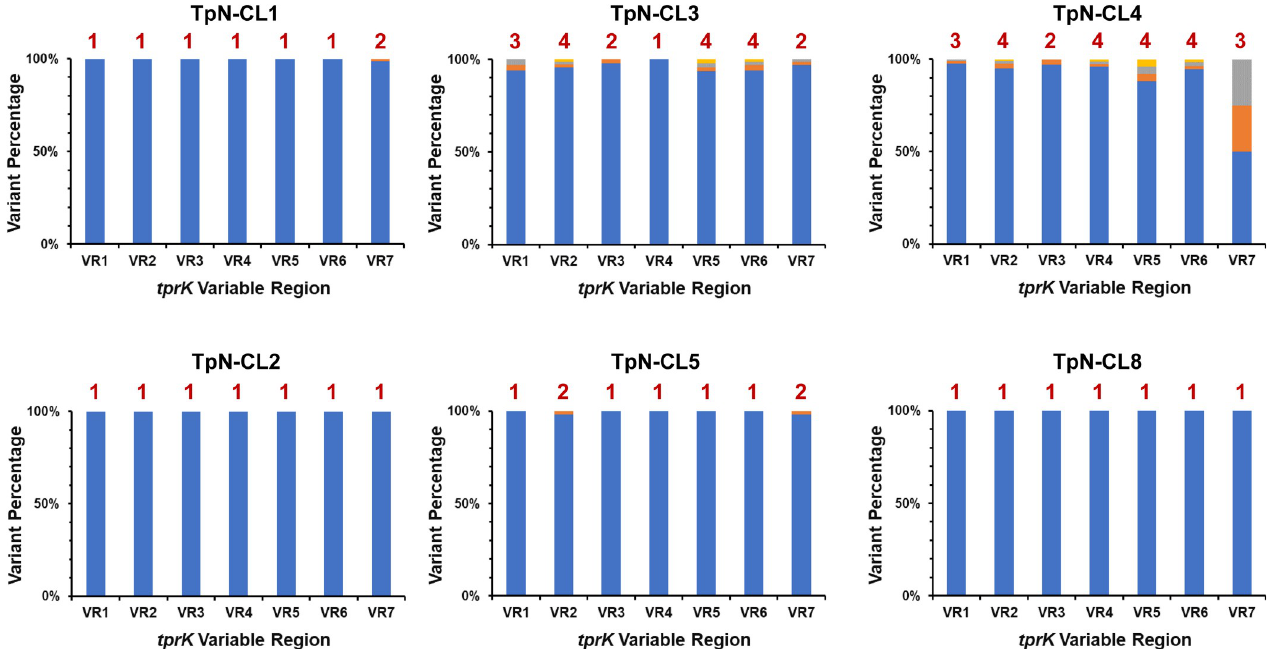
Fig 6. tprK variable regions in the T . pallidum Nichols clones exhibit a low degree of sequence variations. Results were obtained with Illumina sequencing of six T . pallidum Nichols clones generated in vitro . The numbers above the bars indicate the number of different variable region sequences detected. The bar colors are arranged from most frequent to least frequent variant, and do not denote sequence identity or similarity. Either a single or (rarely) two variable region sequences were detected in clones TpN-CL1, TpN-CL2, TpN-CL5, or TpN-CL8, whereas TpN-CL3 and TpN-CL4 had between one and four different variants within each variable